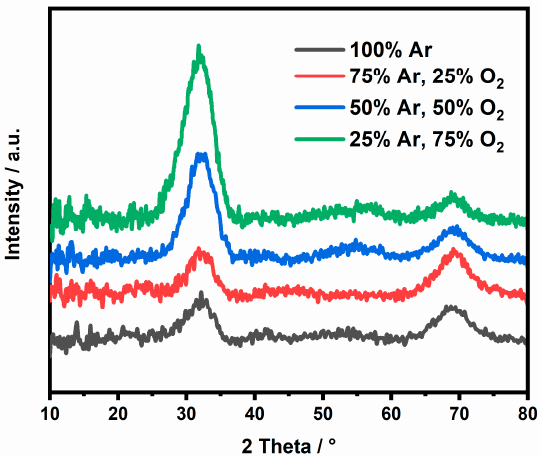
Figure 1. The XRD patterns of the IGZO thin films at different deposition atmospheres.